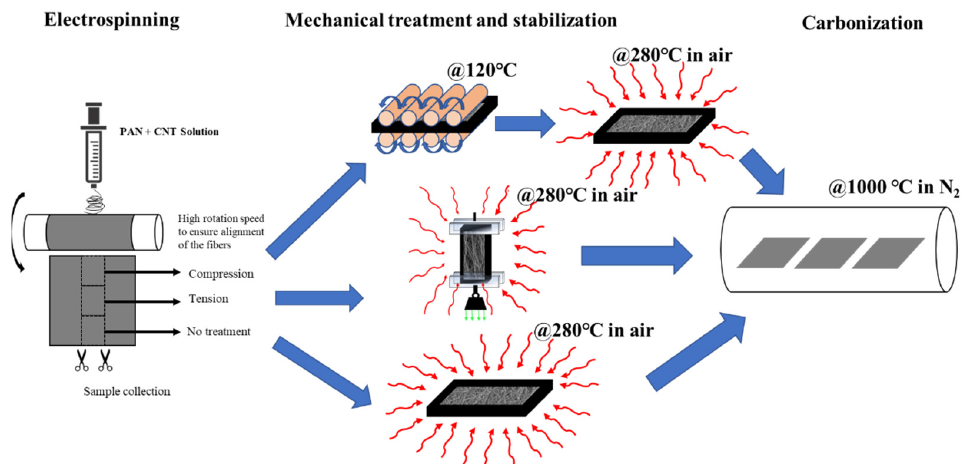
Figure 1. Schematic of manufacturing and stress treatment of PAN/CNT fibers during the stabili- zation process. After electrospinning PAN/CNT nanofiber film on a spinning drum, samples are produced by cutting identical ribbons from the center of the spun mats to ensure uniform thickness. A portion of the sample is treated with compressive stress, while another portion is subjected to tensile stress and following thermal stabilization in air. The remainder of samples were stabilized without any mechanical treatment and as-spun. Then, all samples were pyrolyzed under nitrogen flow at 1000 °C.